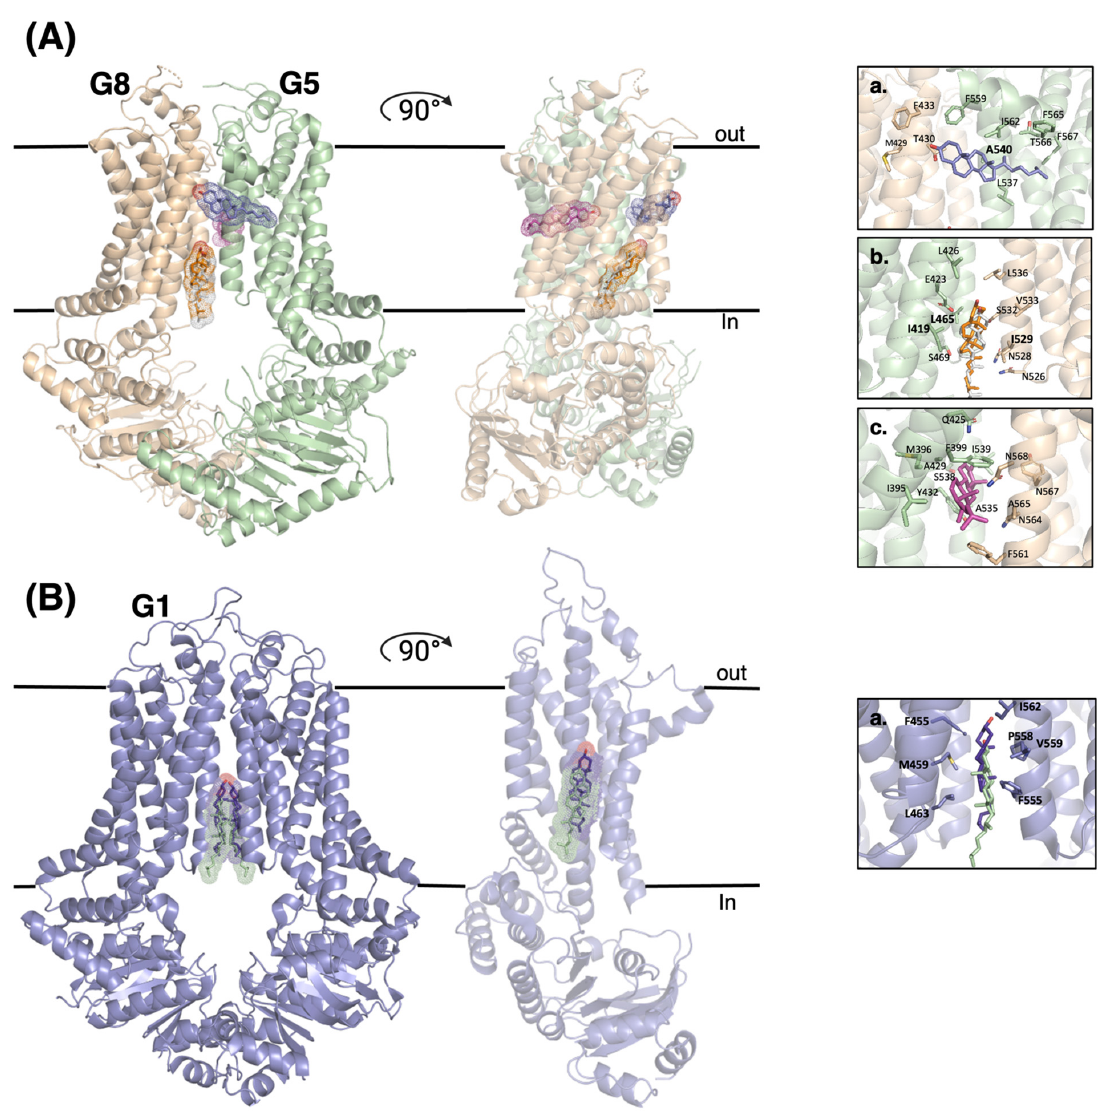
Figure 2. Cholesterol binding sites in the structures of ABCG1 and ABCG5/G8 proteins. ( A ) Com- parison of cholesterol binding sites found on the determined structures of ABCG5/G8, as well as the involving residues. ( a ) This site (Site 3) was found in the crystal structure of ABCG5/G8 (PDB ID: 8CUB). ( b , c ). These binding sites (sites 1 and 2) were observed in the Cryo-EM structures of ABCG5/G8 (PDB ID: 7R8B and 7R8A, respectively). ( B ) Cartoon representation of ABCG1 in complex with two cholesterols forming a binding site. ( a ) Two cholesterol molecules colored in purple and green are from Cryo-EM structures of ABCG1, (PDB ID: 7FDV) and (PDB ID: 7R8D), respec- tively.